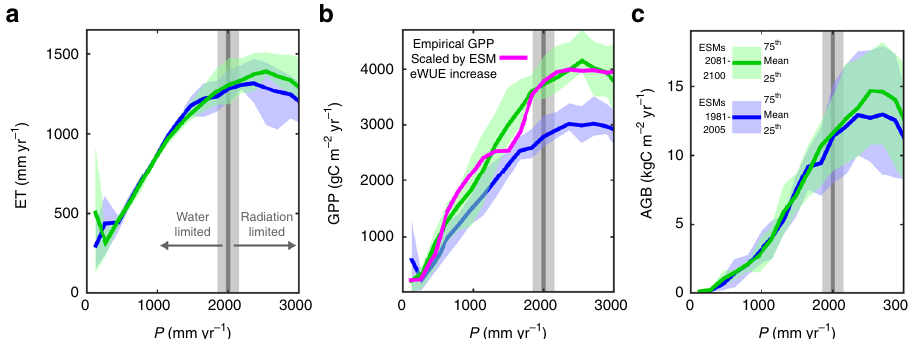
Fig. 6 Future changes in evapotranspiration, gross primary productivity and above ground biomass under RCP 8.5. a Earth system model (ESM) mean and inter-quartile range of historical ( blue ) and future ( green ) evapotranspiration (ET) dependency on precipitation ( P ) The grey line and shading represent the mean and range, respectively, of estimated breakpoints across tropical forest locations globally 21 . b Historic and future gross primary productivity (GPP) dependency on P, coloured for ESMs as in a . The magenta line represent the empirical GPP dependency on P scaled with the ESM ensemble increase in ecosystem water use ef fi ciency (eWUE; 1.31). c Historic and future dependency of above ground biomass (AGB) on P. The eWUE-induced increases seen for GPP do not translate to similar increases in AGB, and are limited to a narrow P range in the radiation-limited regime. In the water-limited regime, AGB does not change, indicating that CO 2 effects on eWUE do not affect AGB in the water-limited regime in